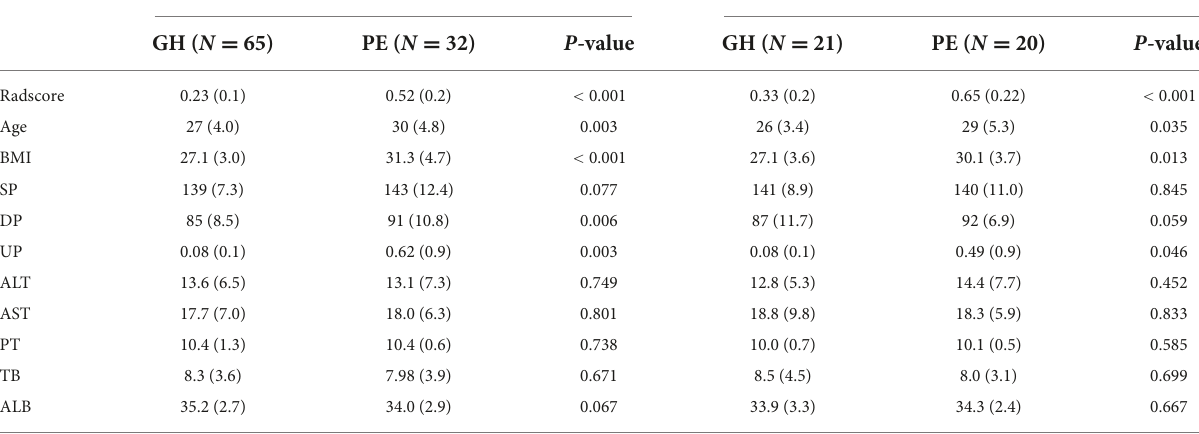
TABLE 1 Clinical characteristics of the training and test cohort.